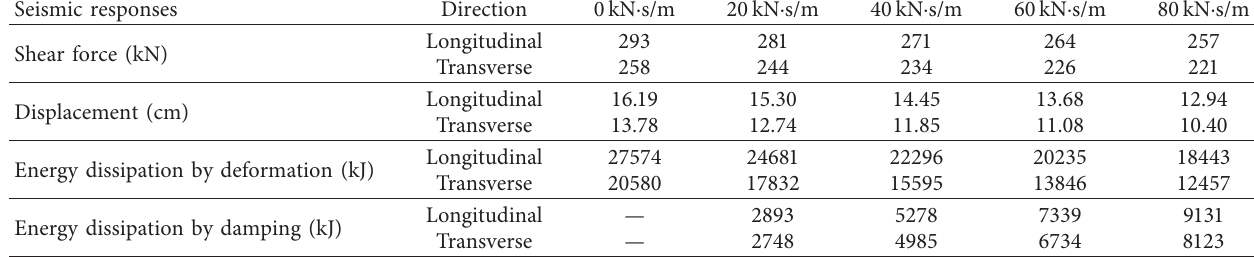
Table 2: Seismic responses of HDR bearings with different dampings.